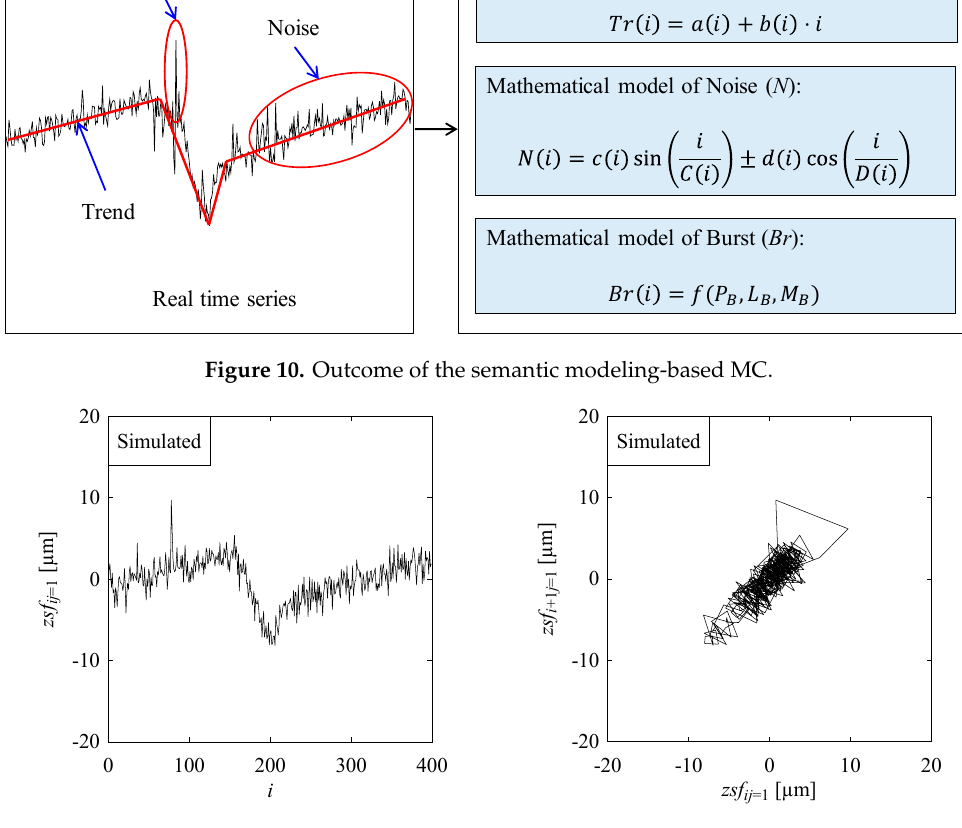
Figure 11. Outcomes of the Monte Carlo simulation-based SC associated with the semantic modeling- based MC: ( a ) simulated surface heights; ( b ) return map of ( a ).